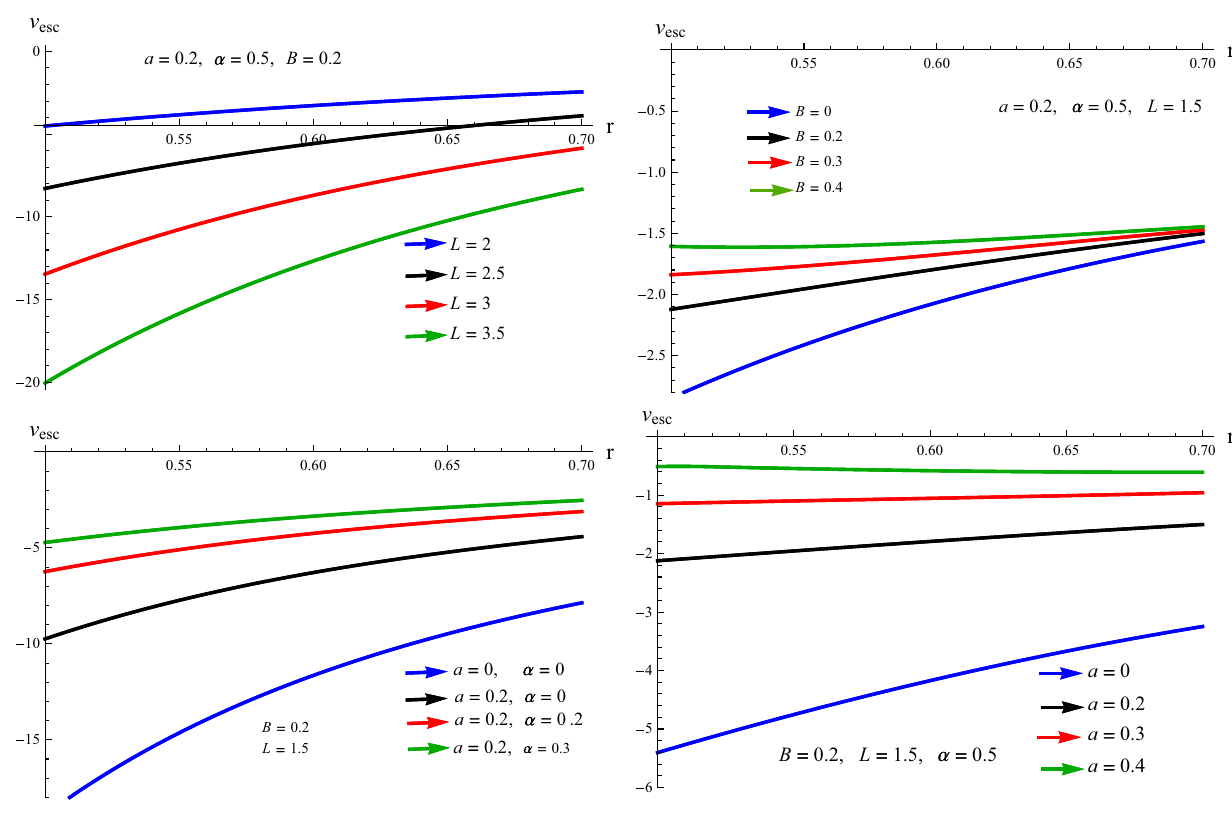
Fig. 1 Escape velocity against r becomes almost constant as the particle moves away from the